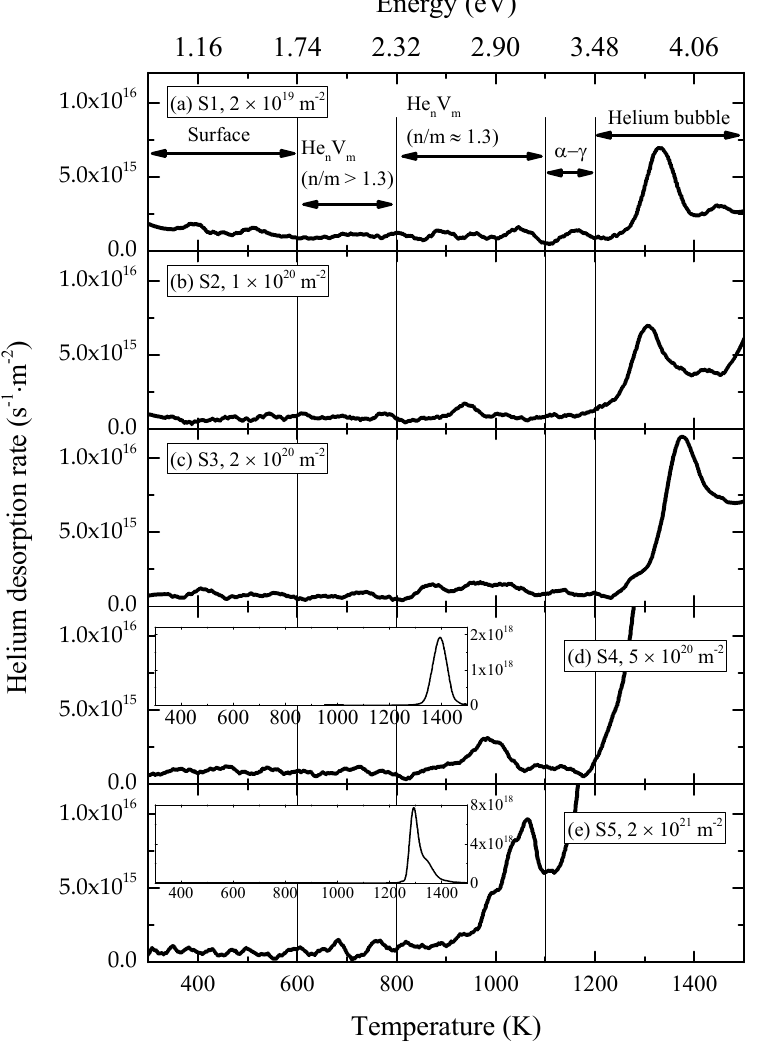
Figure 4. Desorption spectra in specimens irradiated with 100 keV ‐ He + at 523 K to various fluences: ( a ) 2 × 10 19 , ( b ) 1 × 10 20 , ( c ) 2 × 10 20 , ( d ) 5 × 10 20 , and ( e ) 2 × 10 21 m − 2